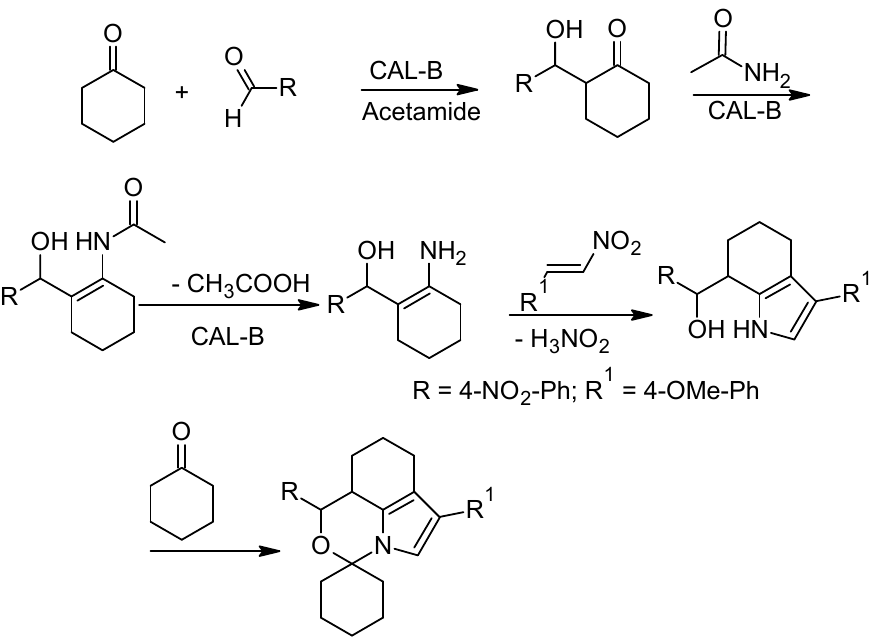
Scheme 23. Mechanism of the enzyme-catalyzed 5-component synthesis of spiro-oxazino